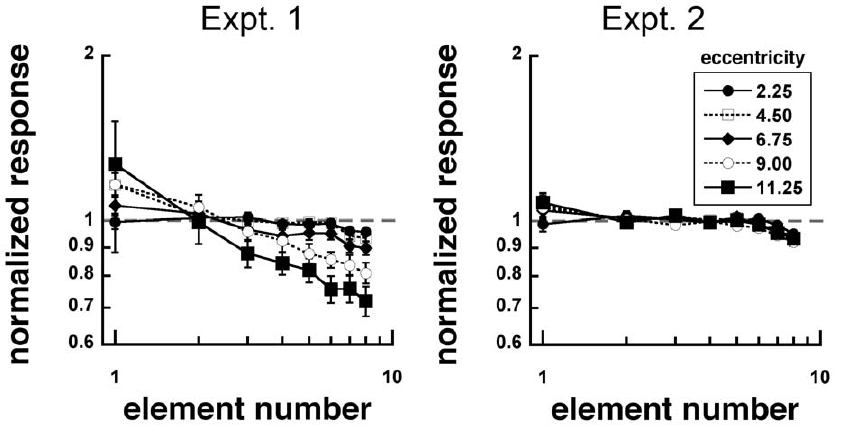
Figure 5. Mean normalized response (mean response/element number) as a function of element number for stimuli with unscaled (Experiment 1) and scaled (Experiment 2) sizes. Deviation from 1 (dashed line) represents inaccurate responses. Above 1 represents overestimation while below 1 represents underestimation.